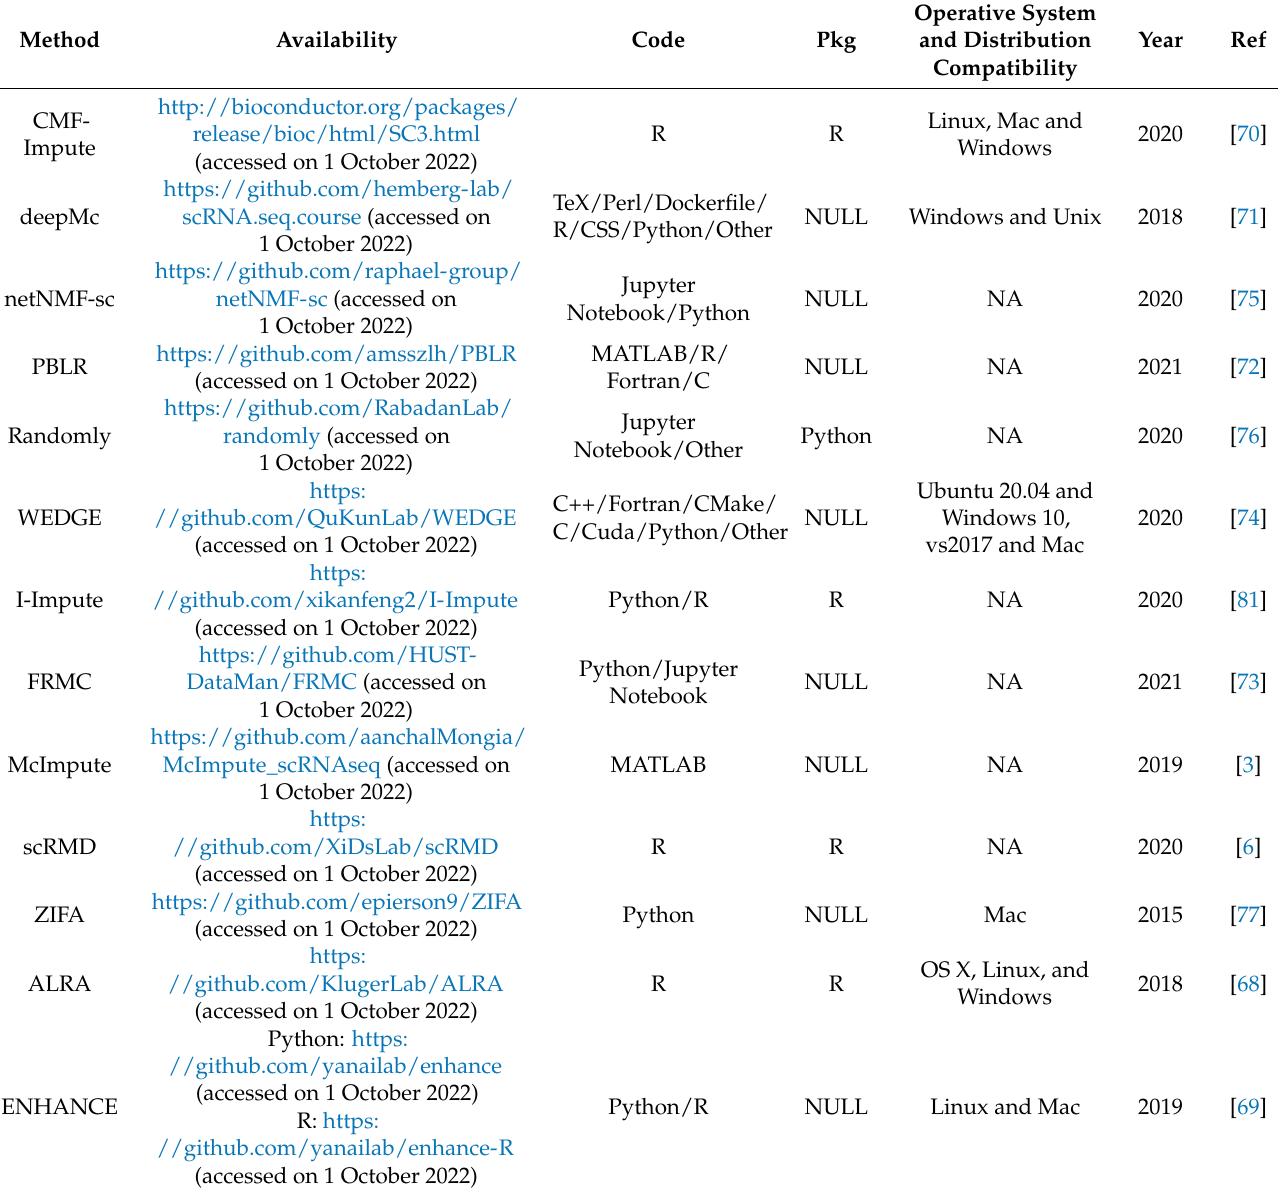
Table 3. The availability links, programming language, whether a package is available, year of presentation, operative system, distribution compatibility and reference of the representative methods based on low-rank